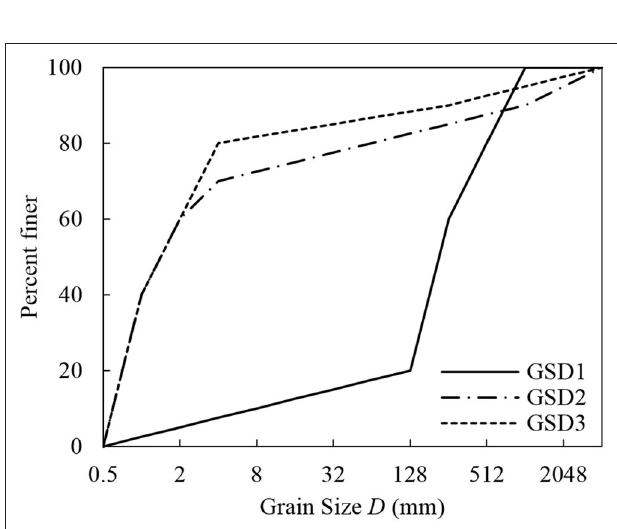
FIGURE 11 | Three GSDs implemented to study the effect of GSD on the hydrograph of breach flood in the case of the “November 3” Baige barrier lake.